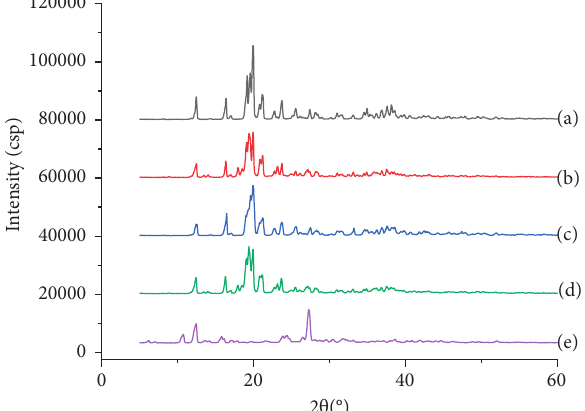
Figure 6: XRD patterns of (A) α -lactose monohydrate, (B) porous lactose, (C) α -lactose monohydrate after quercetin loading, (D) porous lactose particles after quercetin loading, and (E)